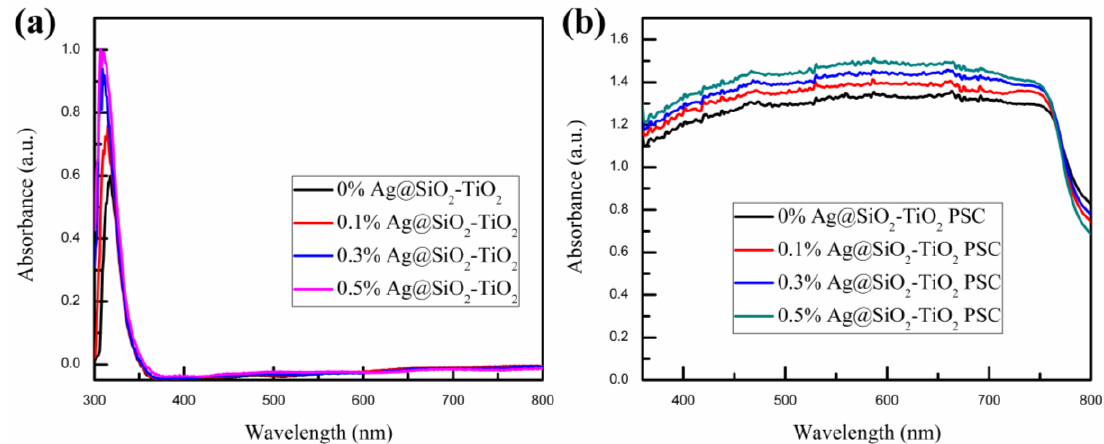
Figure 5. UV-vis absorption spectra of ( a ) pristine TiO 2 and TiO 2 mixed with Ag@SiO 2 NPs mesoporous film samples and ( b ) PSCs with pristine TiO 2 and TiO 2 mixed with Ag@SiO 2 NPs mesoporous film.